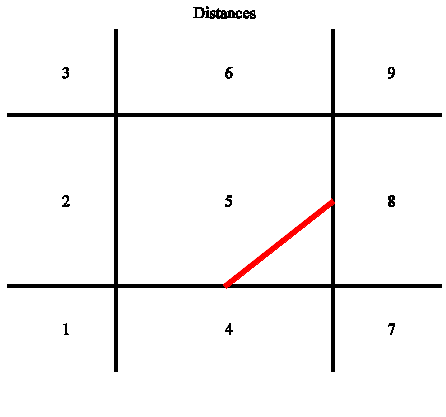
Figure 3. The distances for cells that have to be crossed For this routing case, we simplify matters and test to which extent the NFD can really hold. In fact, the NFD assumes the cells to be homogeneous areas, so a homogeneous speed is assumed. This speed is derived from the properties of the cell using the fundamental equation v = P∕K . From distance and speed the time to go from one neighbouring cell of A to another can be determined. These times are disturbed with a normal error with mean 0 and a standard deviation of 10%. Within this disturbed time, the shortest paths for all cells to all destinations are found using a Floyd-Warshall algorithm. Per cell A it is determined which of the neighbouring cells B is the next cell in the fastest route to destination s . The routing is repeated for different normal random disturbances of the travel times (probit assignment). After these iterations, for each cell A it is stored which fraction of the shortest routes to destination s follows to neighbour B . This fraction,